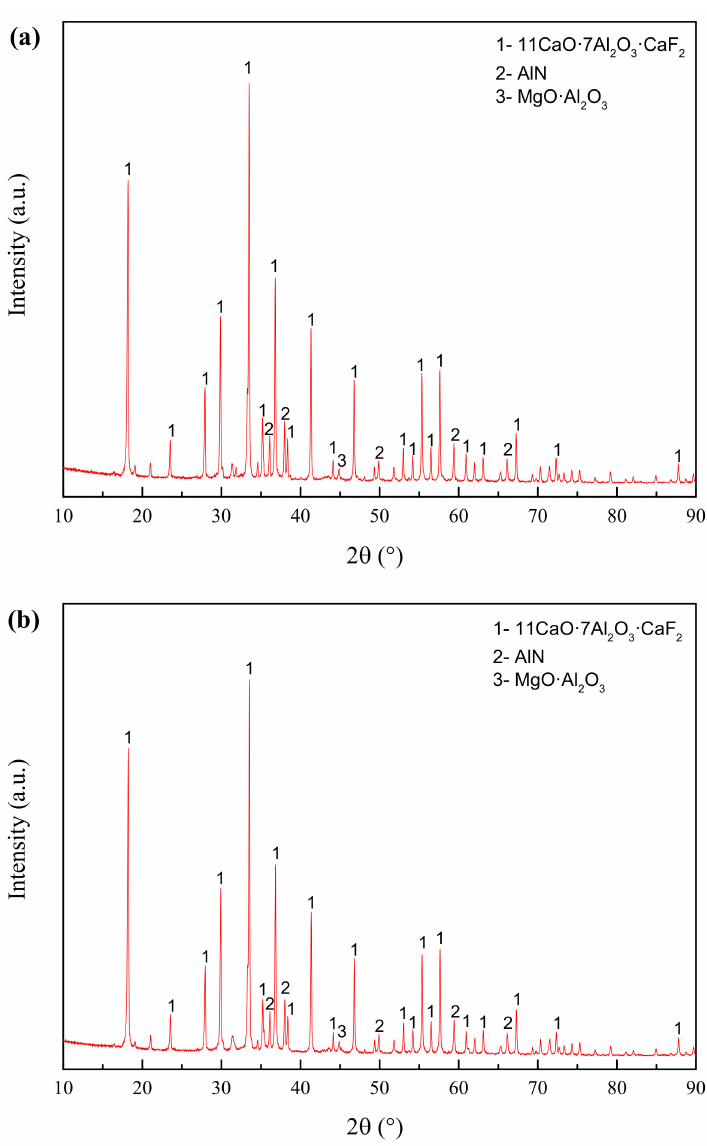
Figure 8. XRD patterns of the premelted calcium aluminate slags. ( a ) Calcinated in N 2 atmosphere; ( b ) calcinated in Ar